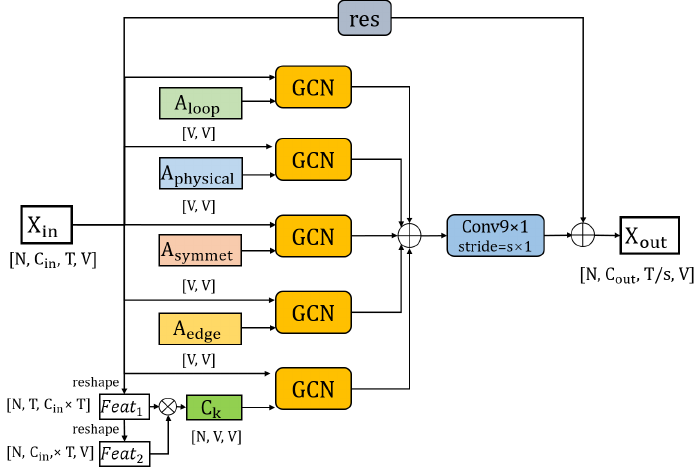
Figure 3. The structure of the WGCN unit. ⊕ denotes the element-wise